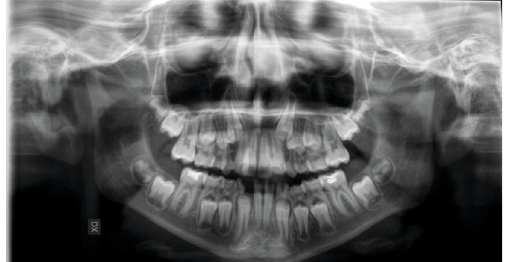
Figure 3: Initial panoramic radiograph.